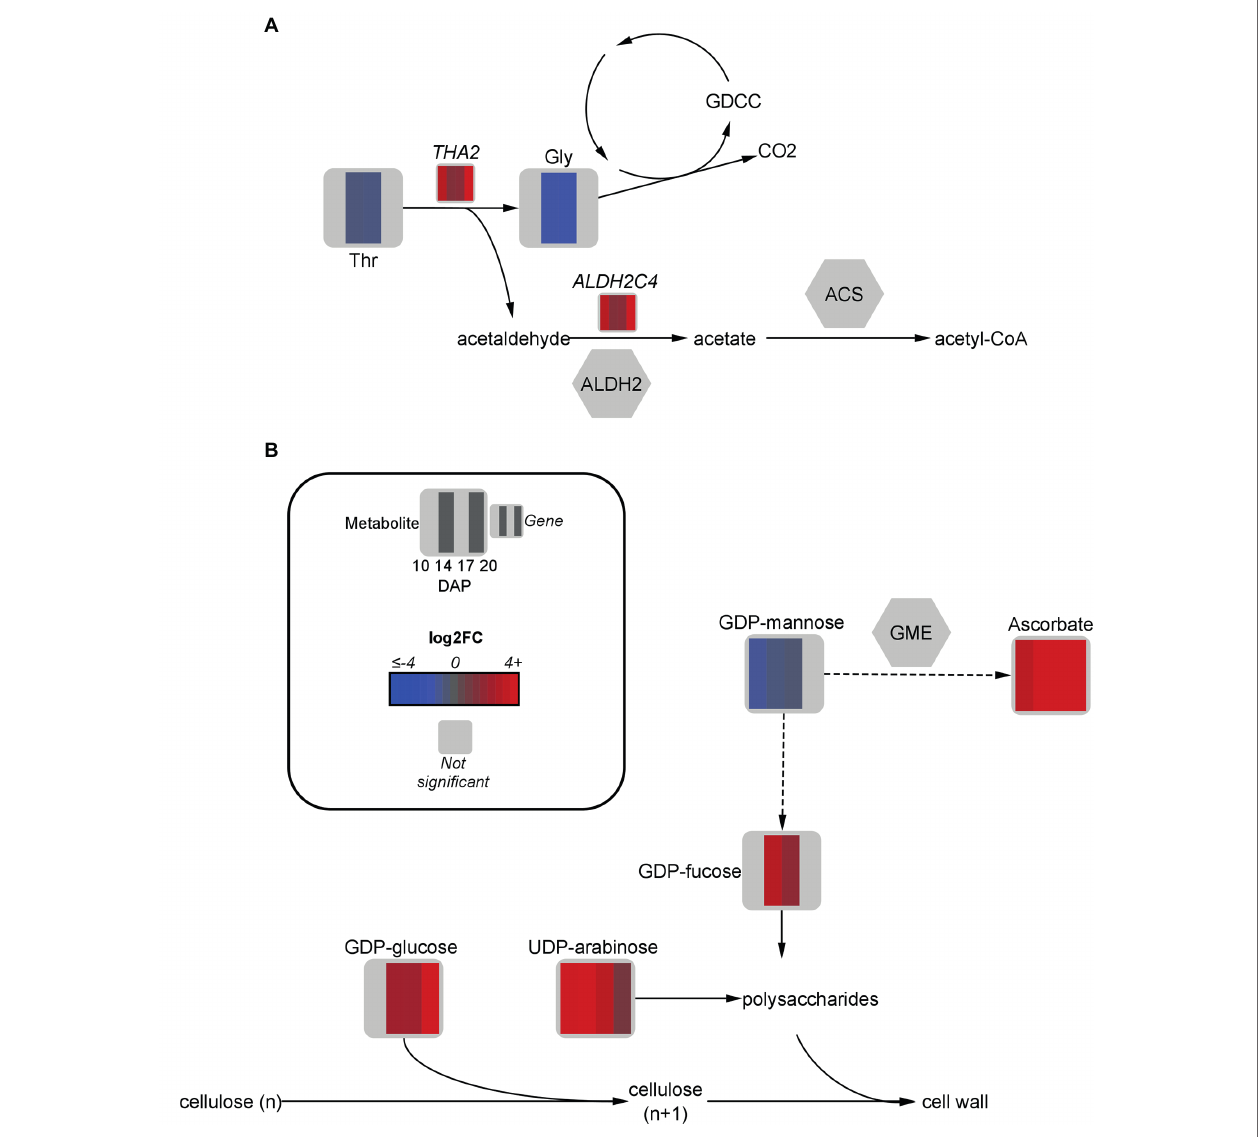
FIGURE 5 | Fold-change of DEGs and significant metabolites involved in threonine metabolism (A) and cell wall metabolism (B) in high oil (HO) and low oil (LO) accessions of pennycress. Data are in log 2 FC in HO with respect to LO. Solid lines indicate single reactions between nodes, whereas dotted lines indicate the presence of more than one reaction. ACS, acetyl-CoA synthase; ALDH, aldehyde dehydrogenase; CO2, carbon dioxide; DXPS, deoxyxylulose phosphate synthase; GDCC, glycine decarboxylase complex; Gly, glycine; GME, GDP-D-mannose 3,5 epimerase; n , number of carbons in cellulose units; PDH, pyruvate dehydrogenase; TDP, thiamine diphosphate; THA, threonine aldolase; Thr,